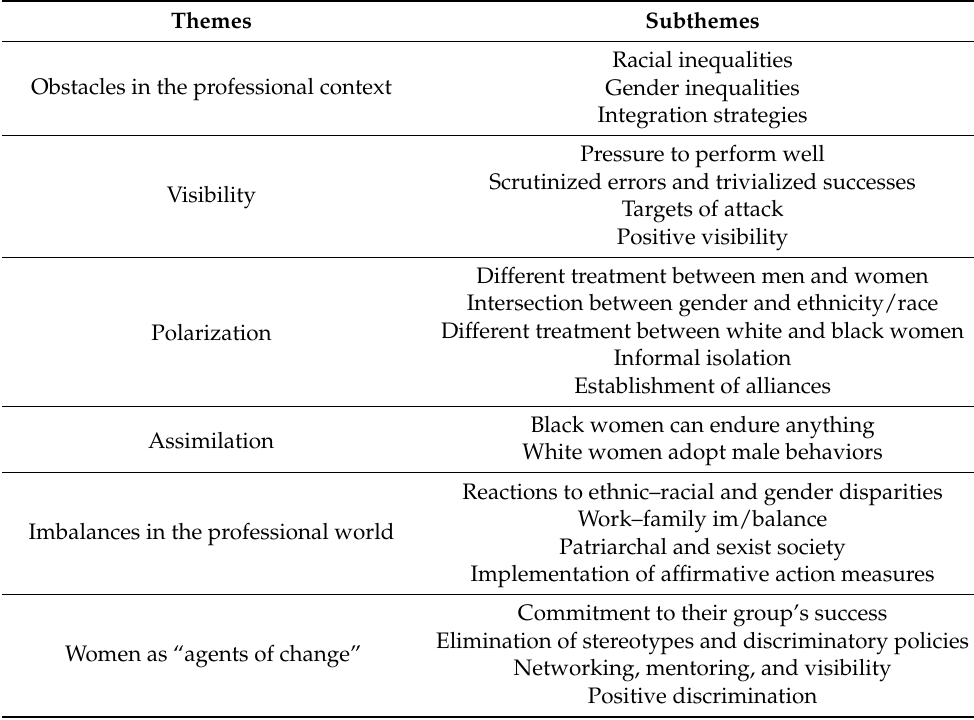
Table 2. Themes and